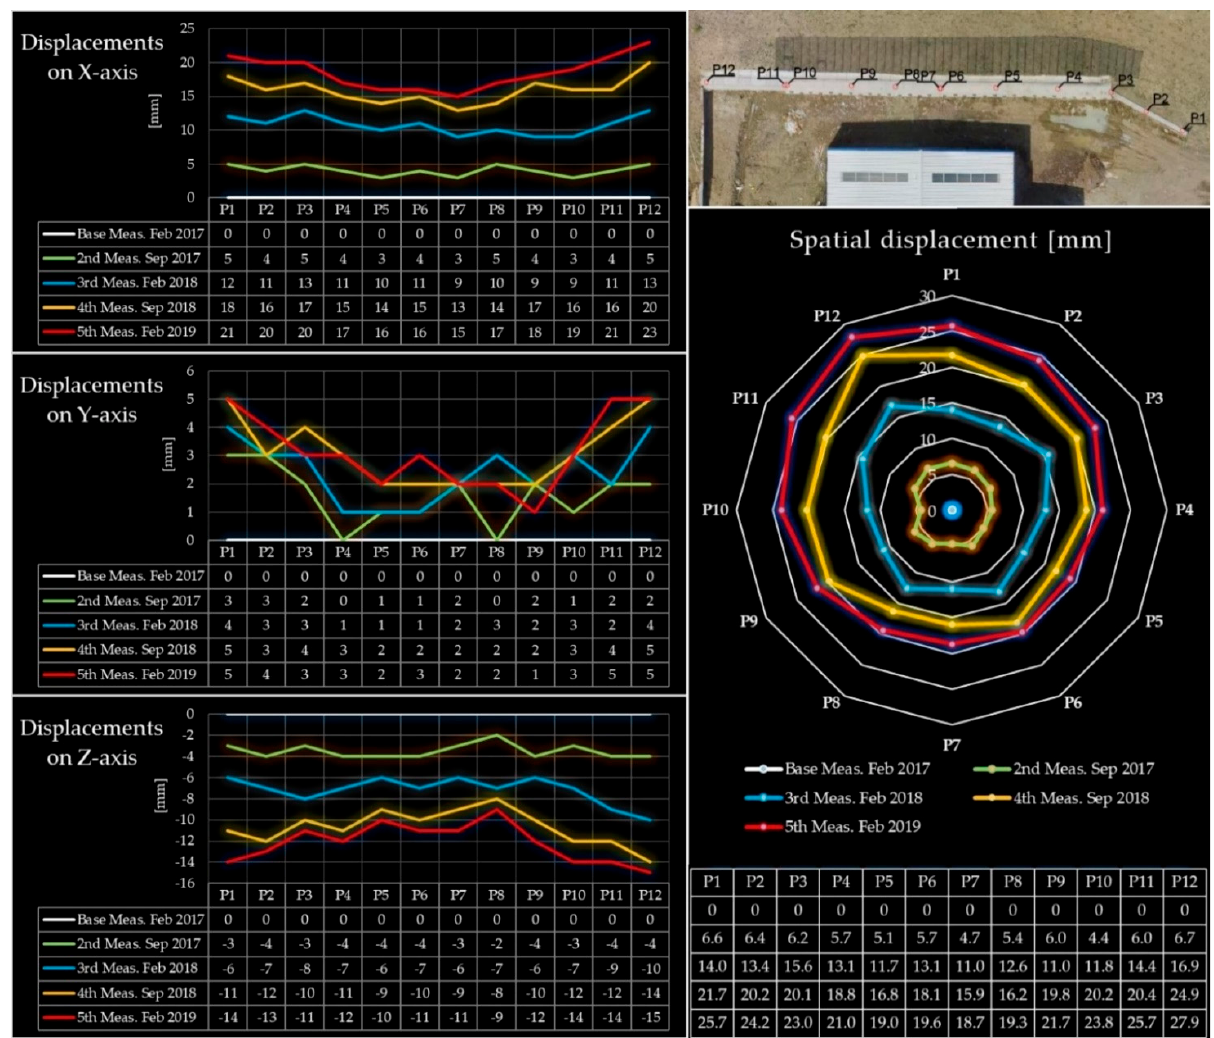
Figure 11. Displacement analysis on each axis, as well as overall spatial values.